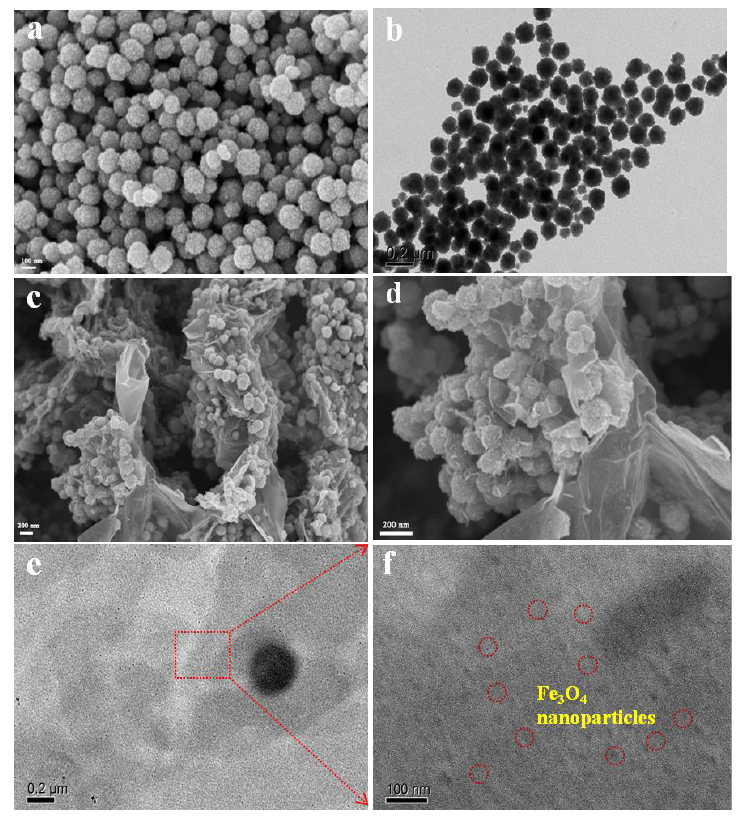
Figure 5. ( a ) SEM; ( b ) TEM images of Fe 3 O 4 ; ( c , d ) SEM; ( e , f ) TEM images of MrGO-2.